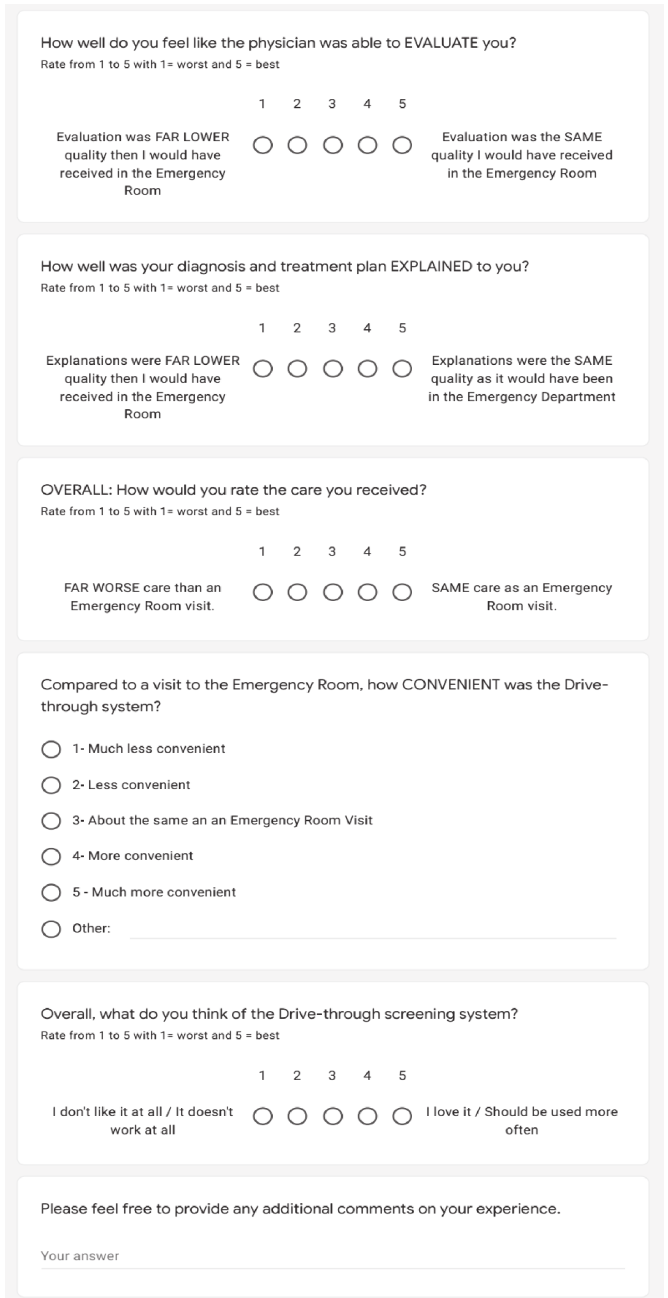
Figure 1. Patient perception survey of a drive-through medical evaluation system.